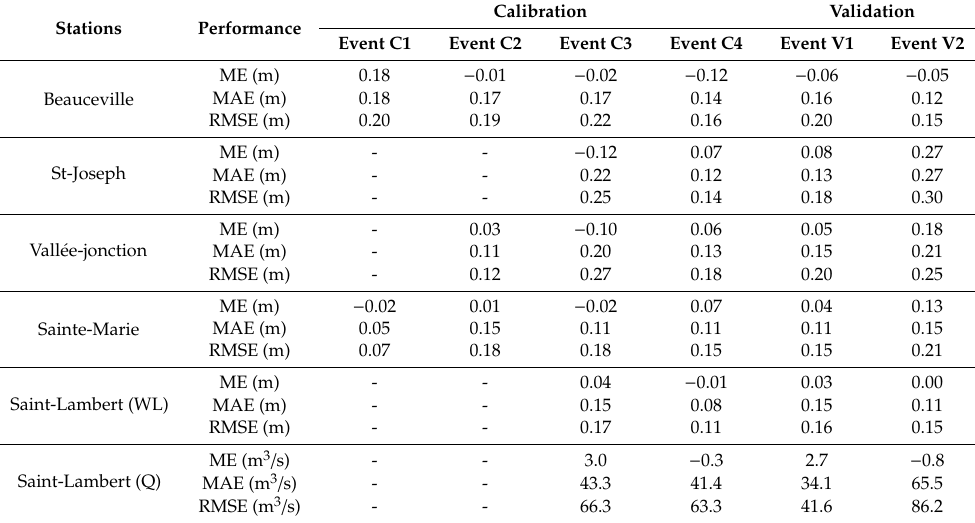
Figure 8. Adaptive flow-based calibration relationships nfac = f ( Q ) developed for the model segments. Table 4. Calibration and validation performance values per event and control site (Mean Error (ME), Mean Absolute Error (MAE), and Root Mean Square Error